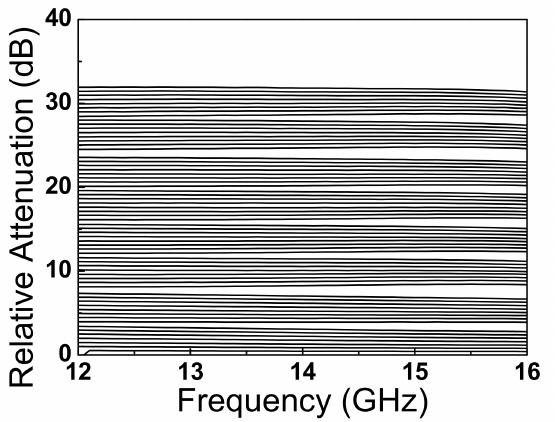
Figure 13. Measured attenuation characteristics of the Ku-band CMOS transmit and